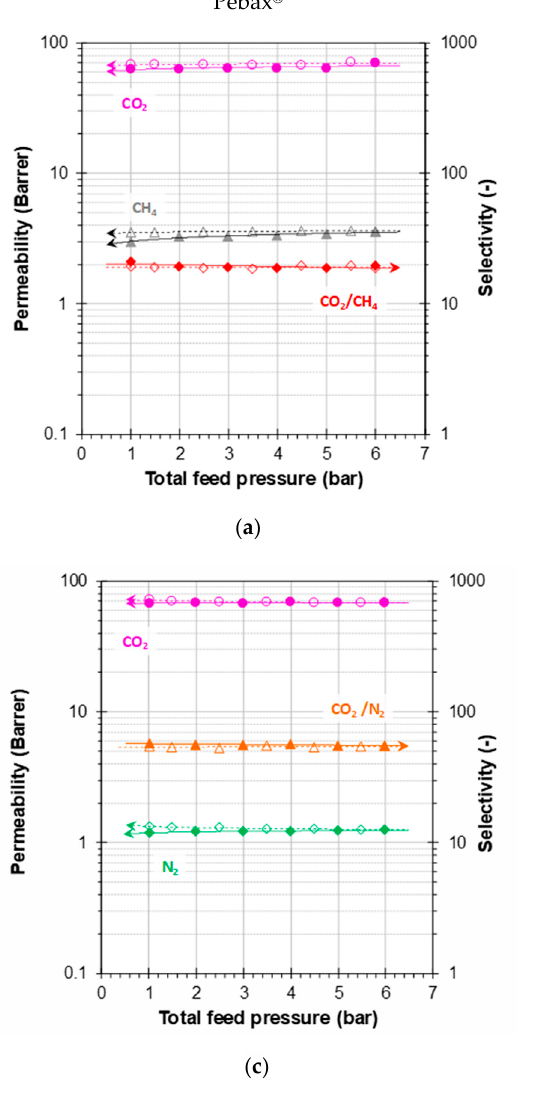
Figure 8. Pressure dependence of CO 2 and CH 4 permeabilities and CO 2 / CH 4 selectivity using the binary mixture of CO 2 / CH 4 (35:65 vol %) for Pebax ® 1657_23 wt % CuNi-MOF ( a ) and PEEK-WC_23% CuNi-MOF ( b ). Pressure dependence of CO 2 and N 2 permeabilities and CO 2 / N 2 selectivity in binary mixture conditions for CO 2 / N 2 (15:85 vol %) of Pebax ® 1657_23 wt % CuNi ( c ) and PEEK-WC_23% CuNi ( d ). Closed symbols for stepwise increase of the pressure and open symbols for the subsequent stepwise decrease of the pressure. Trend lines are plotted as a guide to the eye.